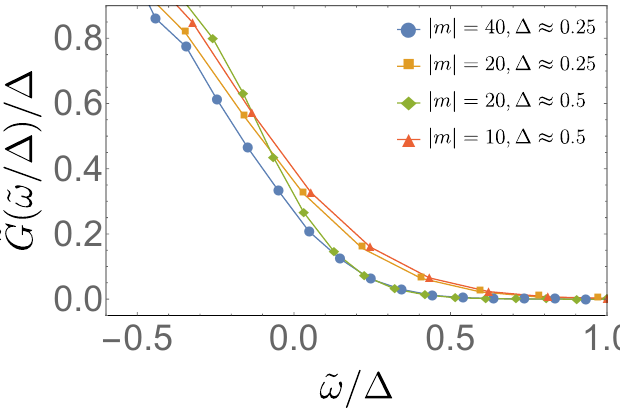
Figure 4: (color online) The power spectra rescaled to account for both proper-time difference of inequivalent observers and the difference in the density of states